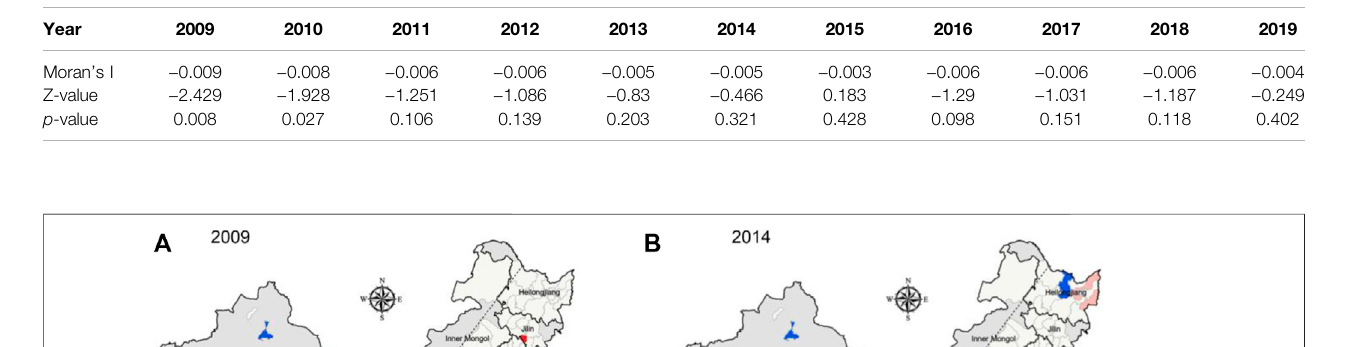
Frontiers in Environmental Science |